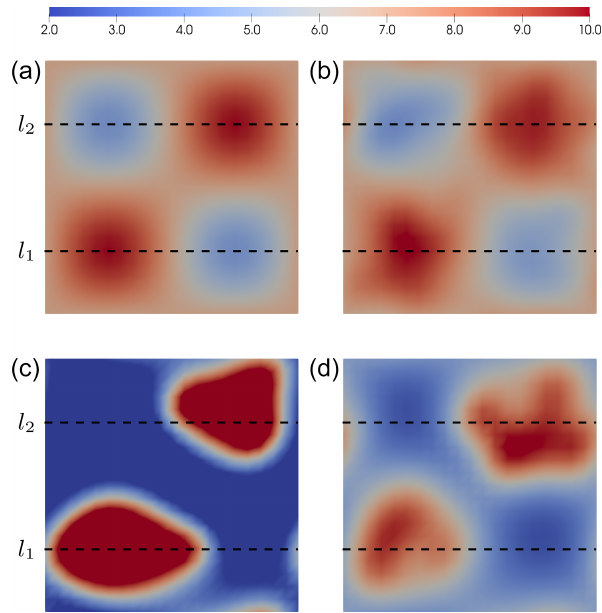
Figure 13. Basal sliding parameter estimates. (a, b) The true basal sliding coefficient (a) and the accurate MAP estimate β REF d) The conventional error model MAP estimate β CEM Bayesian approximation error MAP estimate β BAE black lines are used to show the location of the cross sections ( l 1 = 2 . 5km and l 2 = 7 . 5km) for Fig. 14.